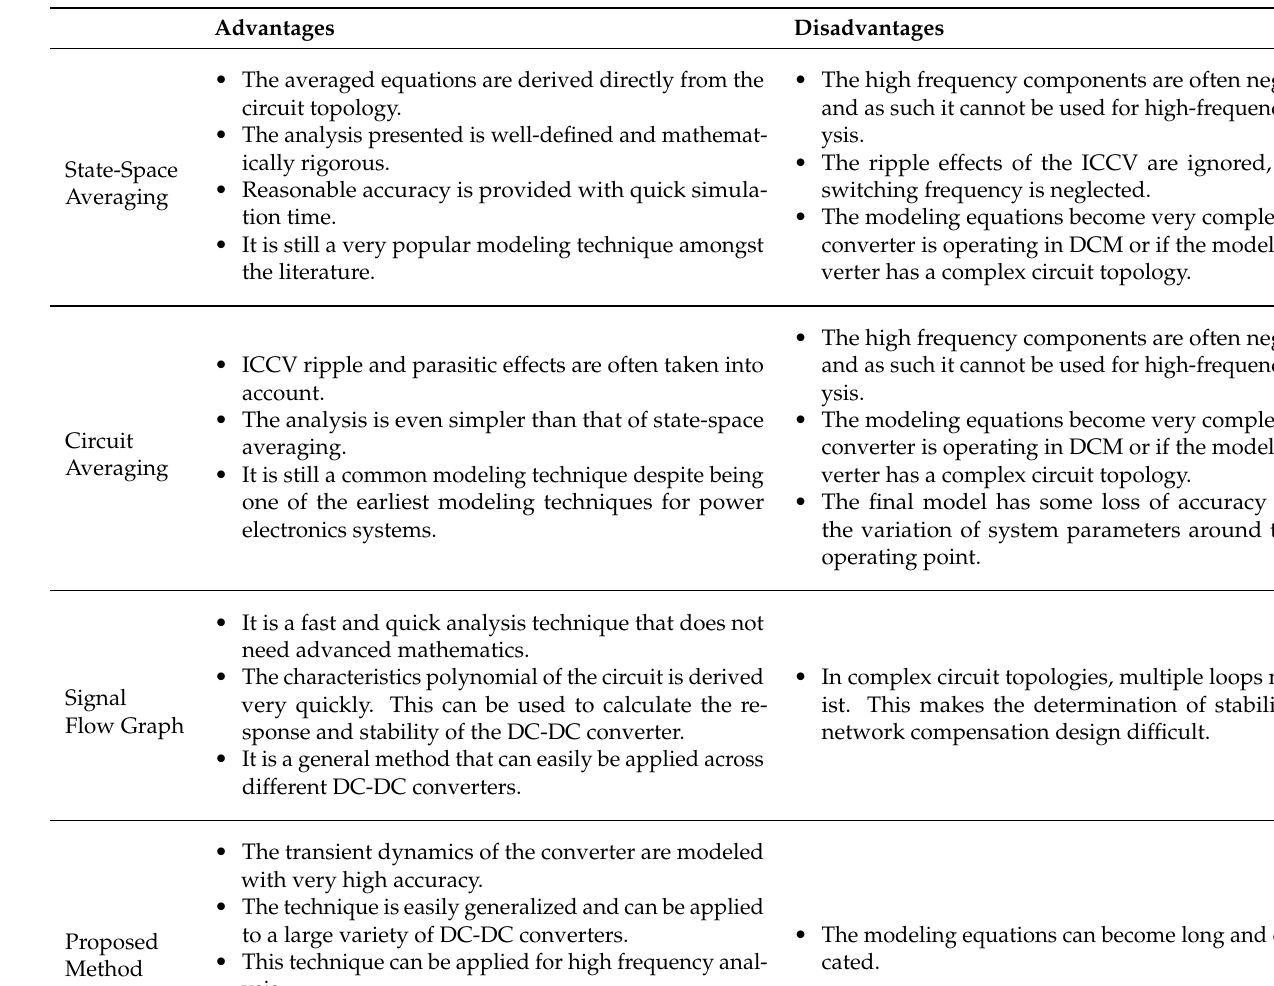
Table 1. Summary of advantages and disadvantages of different power electronics DC-DC converter systems across the